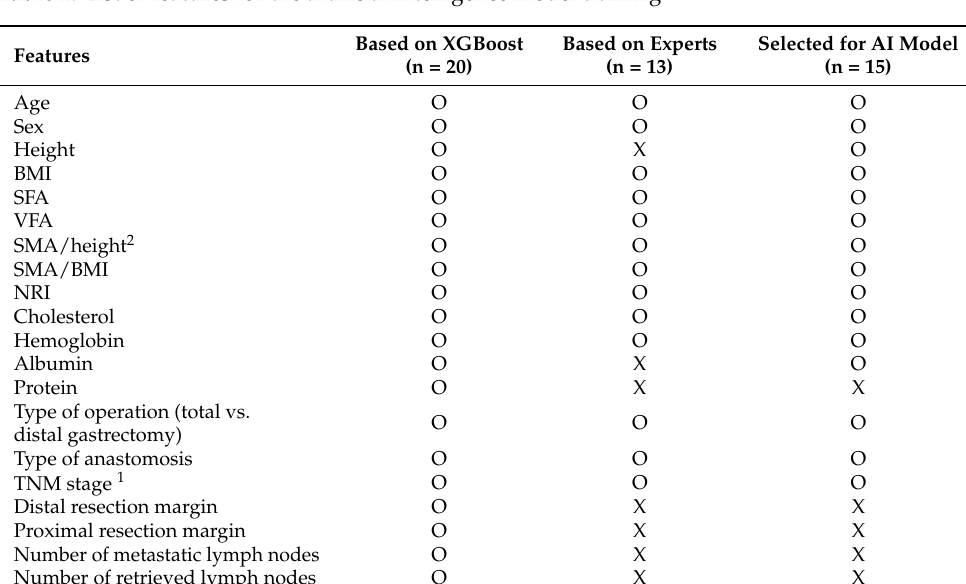
Figure 4. Feature importance of XGBoost. Among 47 features, 20 features were selected through a comparison of feature importance of XGBoost. BMI = body mass index. Table 2. List of features for the artificial intelligence model training.